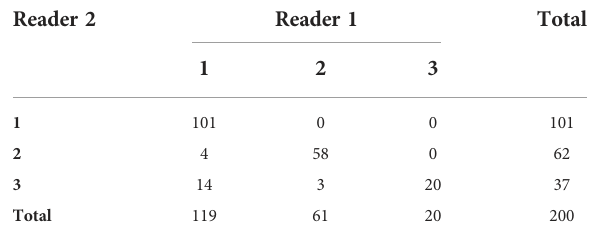
TABLE 2 The intra-observer variability in visual results by the two